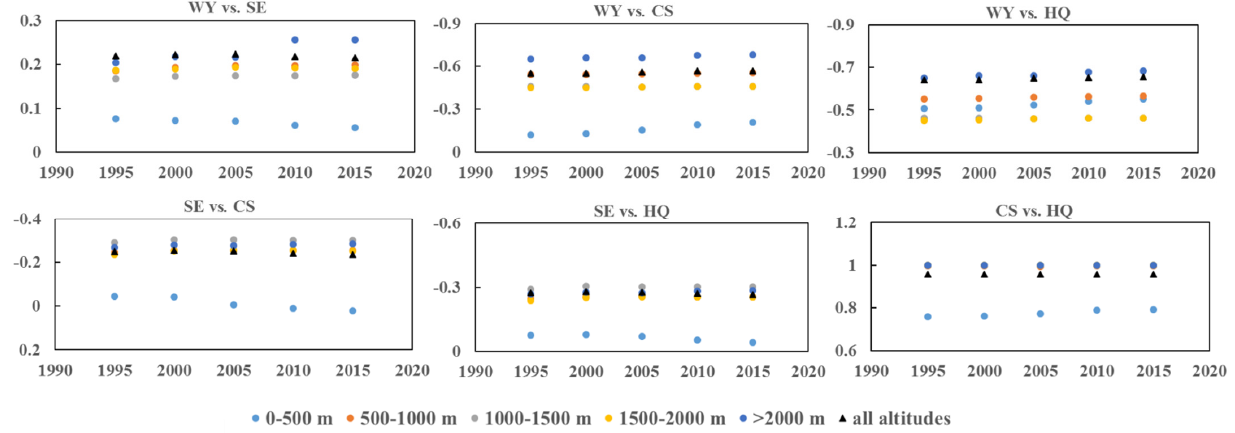
Figure 8. The relationships between ecosystem services from 1995 to 2015. Notes: XX vs. XX represents the relationship of XX and XX (i.e., WY vs. CS indicated the relationship between WY and CS, the same as below). The different colored dots represent the relationships between ecosystem services at different altitudes. The black triangles indicate the relationships between ecosystem services for the whole region. The numbers on the Y ‐ axis are the Pearson’s correlation coefficients between pairs of ESs.